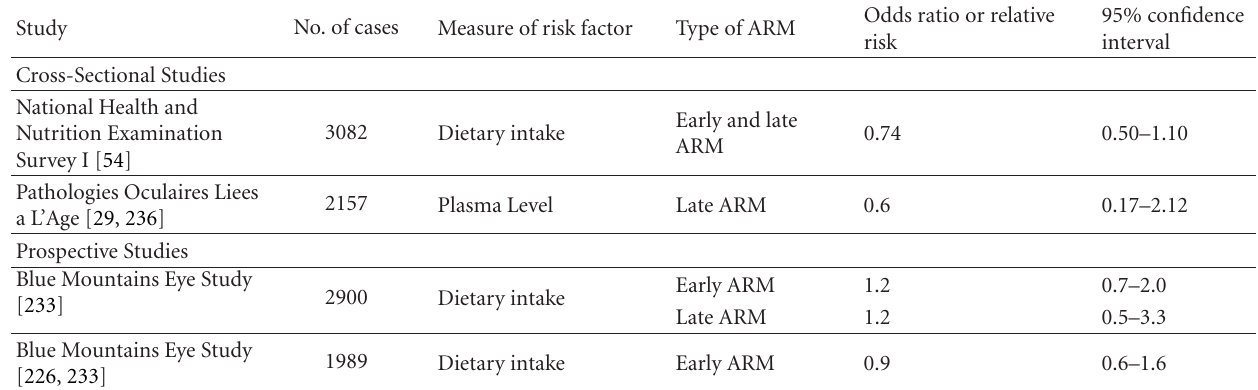
Table 11: Studies investigating the relationship between vitamin A and risk for